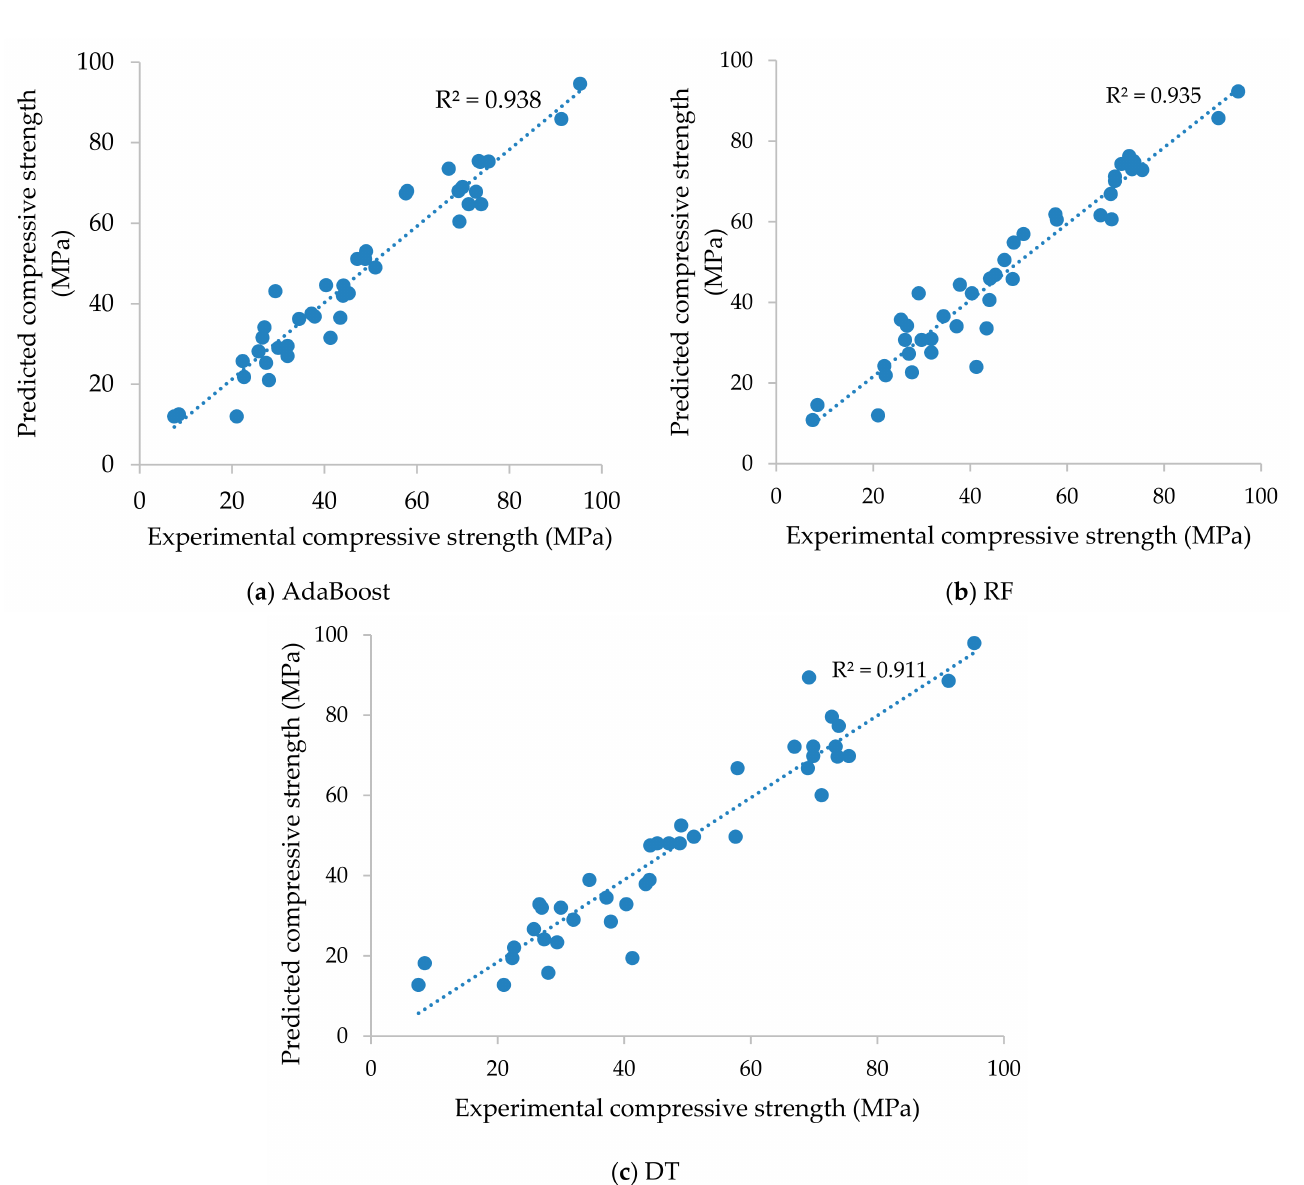
Figure 4. Scatter plot presenting the experimental (actual) compressive values versus the predicted compressive values of concrete at high temperature of the testing dataset using the ( a ) AdaBoost, ( b ) RF, and ( c ) DT